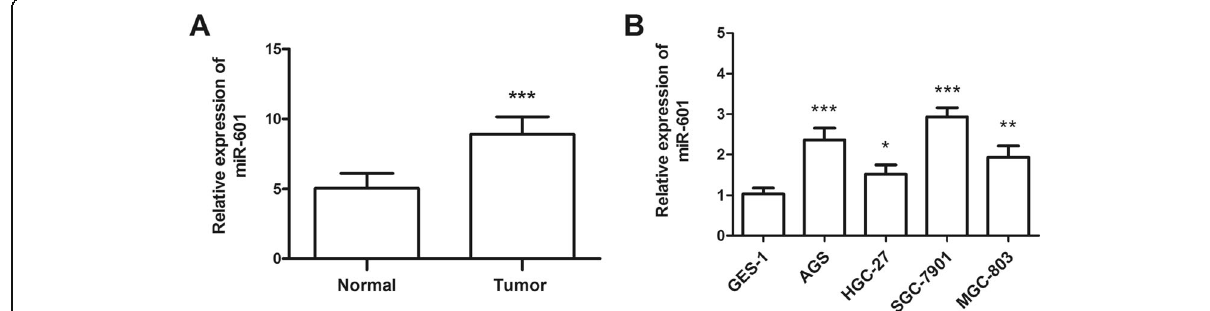
Fig. 1 Expression of miR-601 measured by qRT-PCR in GC tissues and cell lines. a MiR-601 expression was upregulated in the GC tissues compared with the adjacent normal controls, which were calculated according to the mean value from 139 GC patients (*** P < 0.001). b The expression of miR-601 was higher in the GC cell lines than that in the normal gastric cells (* P < 0.05, ** P < 0.01 and *** P < 0.001)